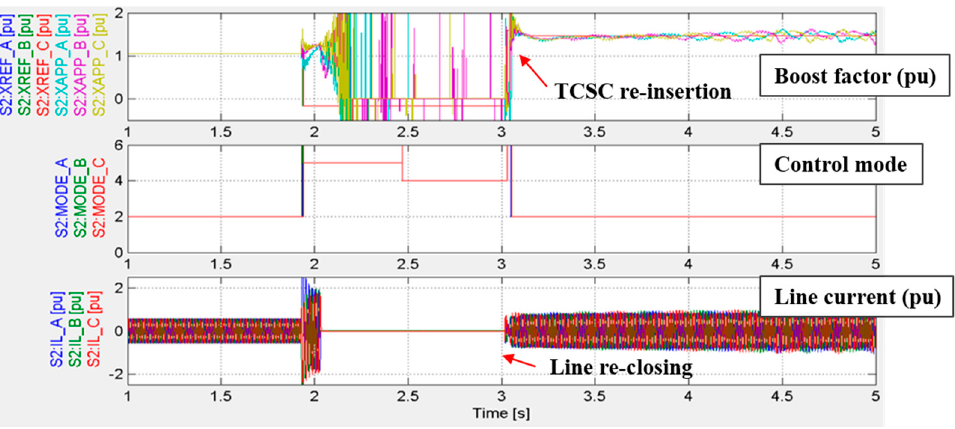
Figure 8. TCSC boost factor (before improvement).